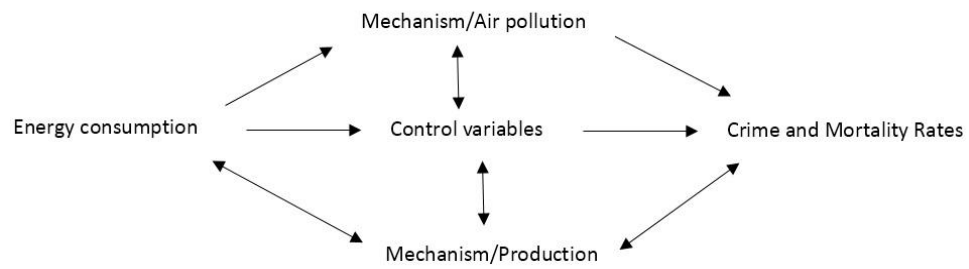
Figure 1. Illustrating the applied empirical model, and the channels of the impacts of each variable on crime and mortality rates.